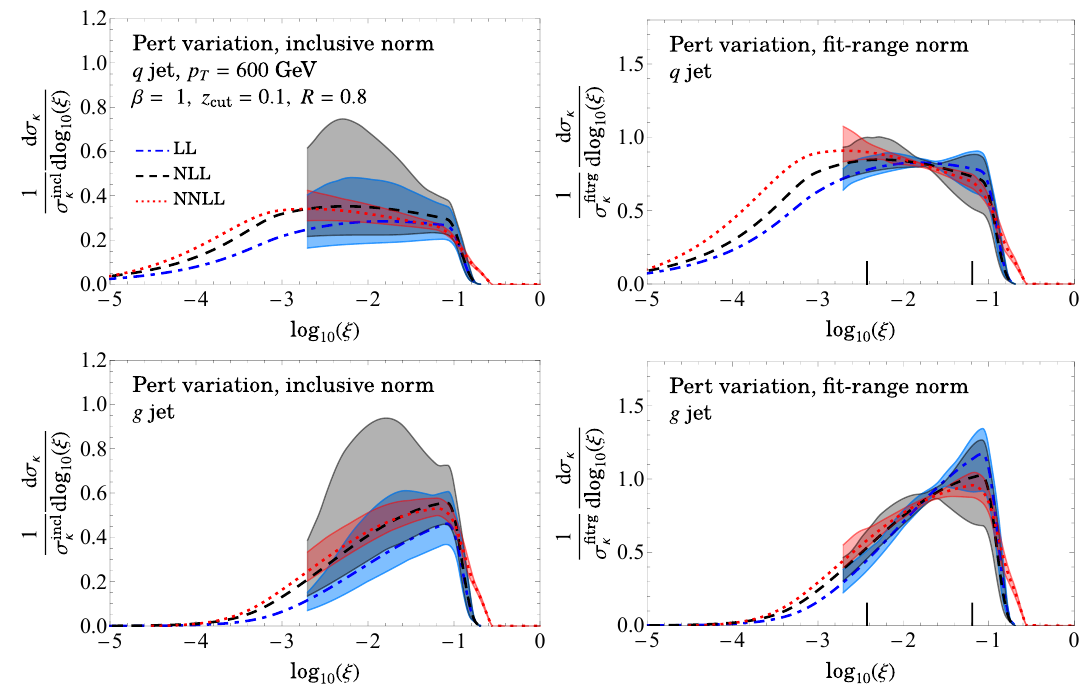
Figure 9 . An envelope of the profile variations for quark and gluon jets respectively, at LL, NLL and NNLL. The perturbative uncertainties are only shown just beyond the fit range considered for α s -sensitivity analysis. The pinching in the uncertainties in the plots in the right column results from the fit range